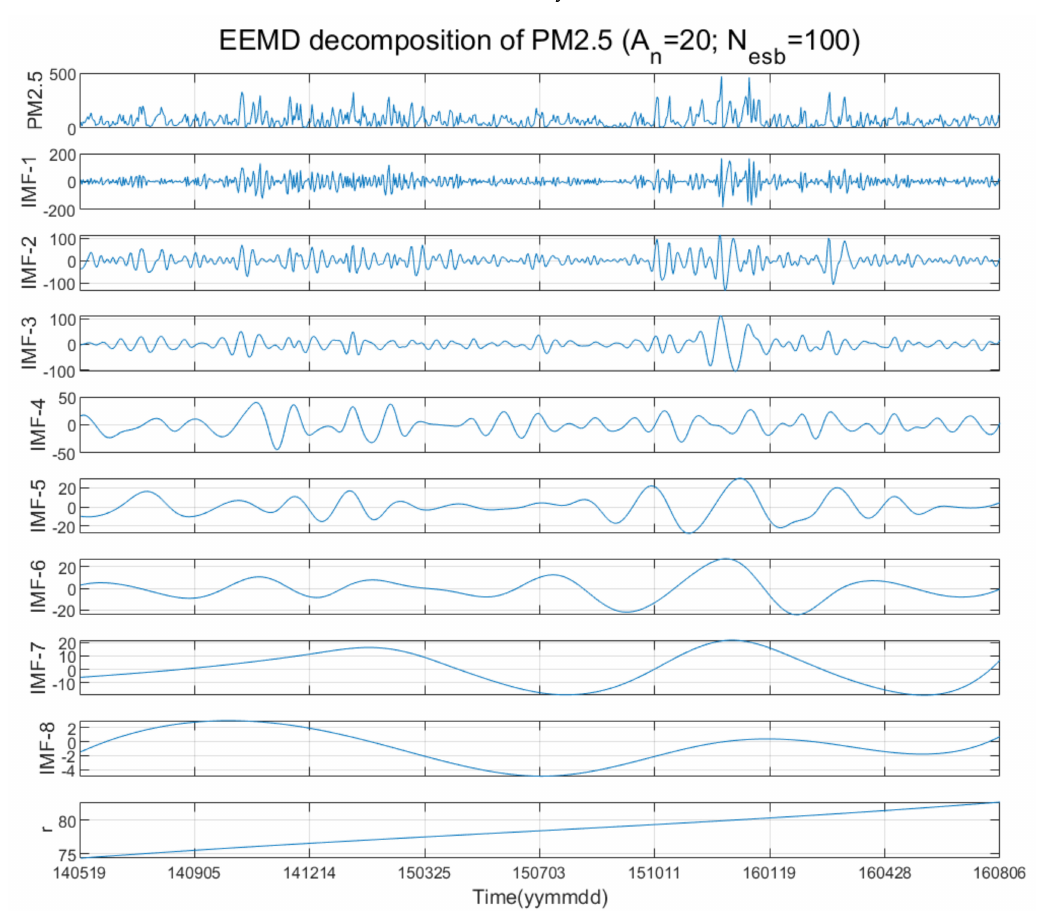
Figure 1. PM 2.5 original sequence and decomposed IMFs. IMFs 1–8 are the eight intrinsic modal functions, corresponding to high to low frequencies. Among them, the IMF-1,2 stand for daily to weekly variability in a time scale of 4.9 to 9.9 days, the IMF-3,4 for monthly variability (18.1 to 39.4 days), the IMF-5,6 for intra-seasonal to seasonal variability, the IMF-7,8 for annual cycles, and the IMF-9 (r) is the